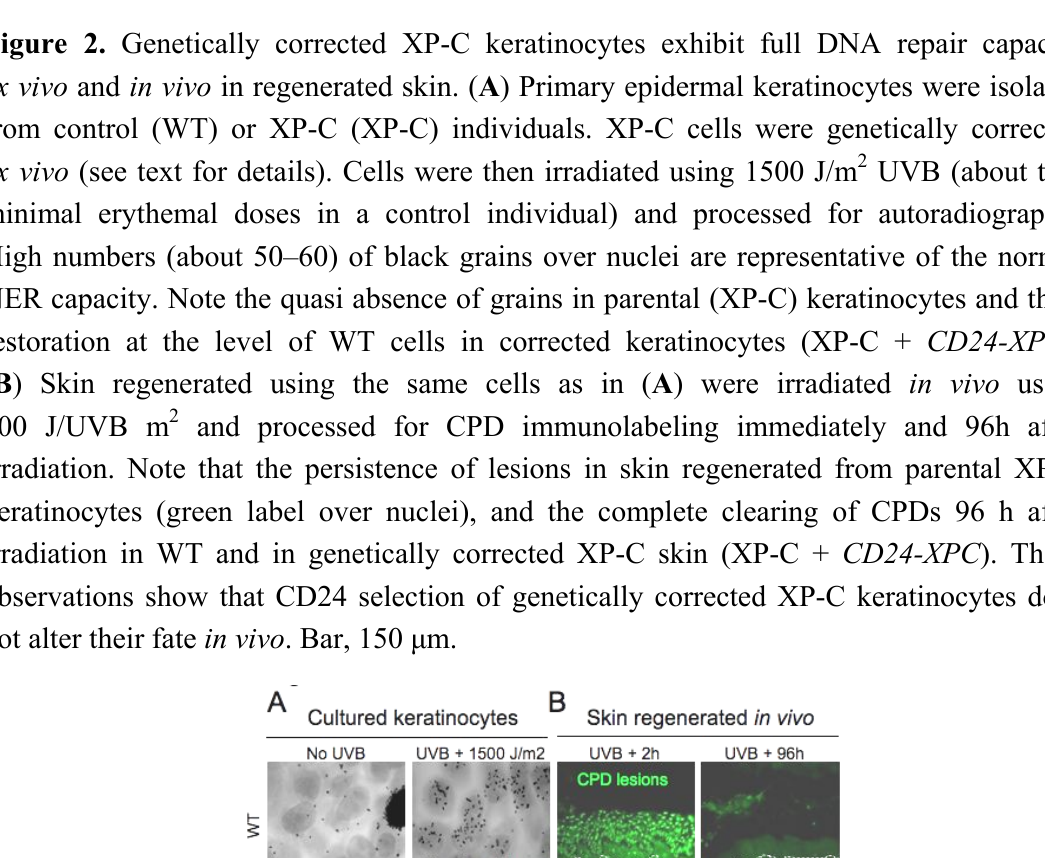
Figure 2. Genetically corrected XP-C keratinocytes exhibit full DNA repair capacity ex vivo and in vivo in regenerated skin. ( A ) Primary epidermal keratinocytes were isolated from control (WT) or XP-C (XP-C) individuals. XP-C cells were genetically corrected ex vivo (see text for details). Cells were then irradiated using 1500 J/m 2 UVB (about two minimal erythemal doses in a control individual) and processed for autoradiography. High numbers (about 50–60) of black grains over nuclei are representative of the normal NER capacity. Note the quasi absence of grains in parental (XP-C) keratinocytes and their restoration at the level of WT cells in corrected keratinocytes (XP-C + CD24-XPC ). ( B ) Skin regenerated using the same cells as in ( A ) were irradiated in vivo using